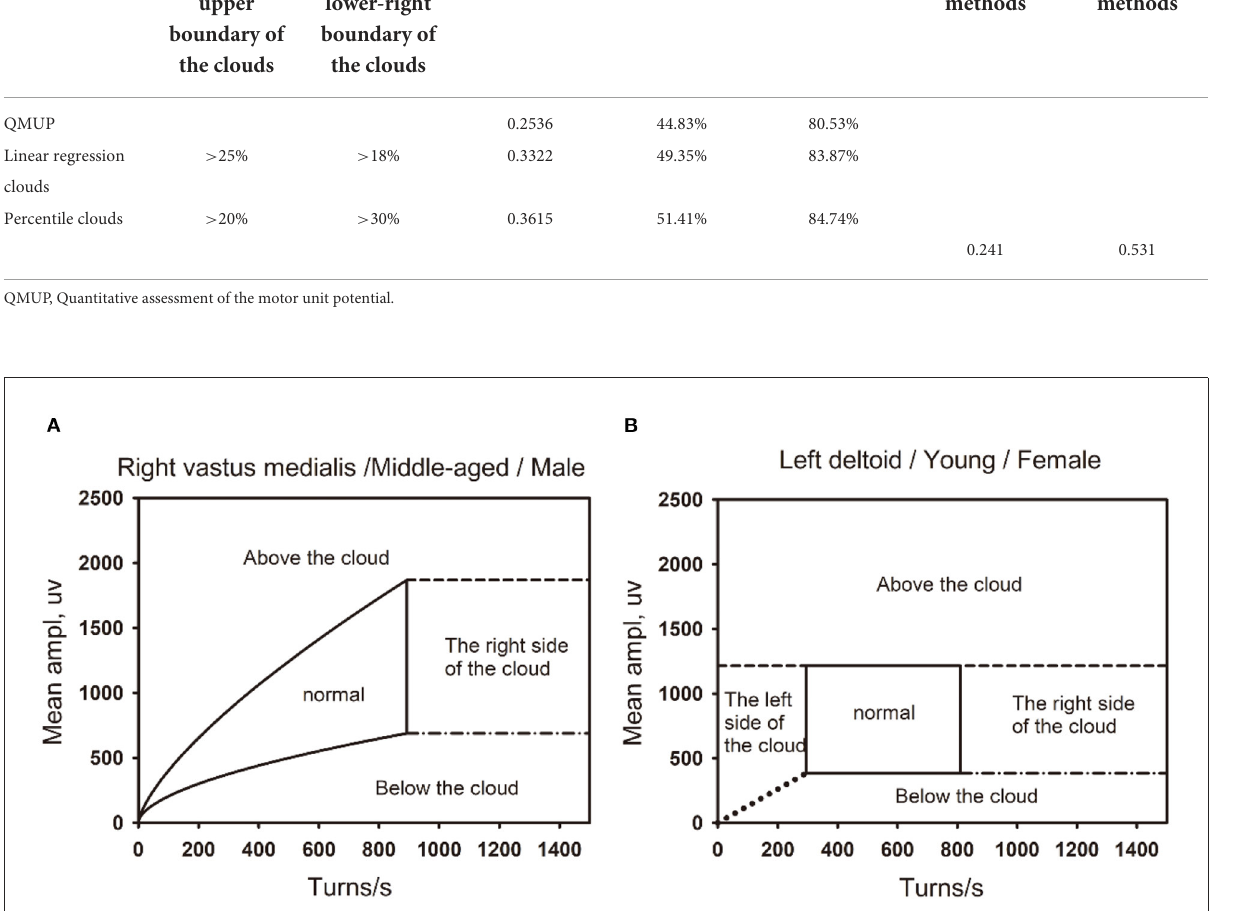
FIGURE6 The boundaries of the the linear regression clouds and percentile clouds are shown in the figure. (A) The normal linear regression clouds and its boundary. The right vastus medialis muscle in a middle-aged (45–59) male. (B) The normal percentile cloud and its boundary. The left deltoid muscle in a Young-aged (18–44)